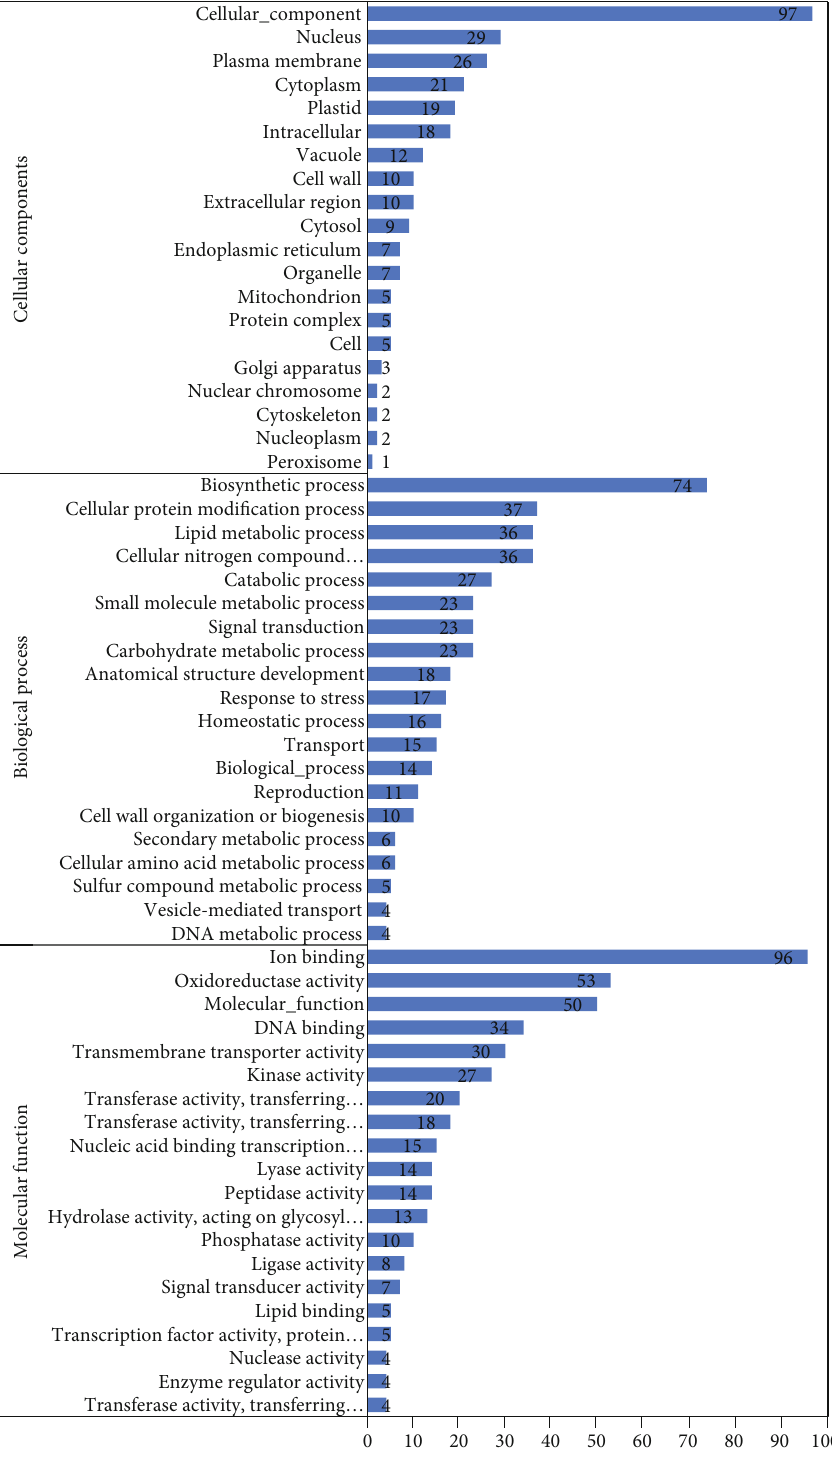
Figure 2: Upregulated GO terms identi fi ed in C. tetragonoloba under drought